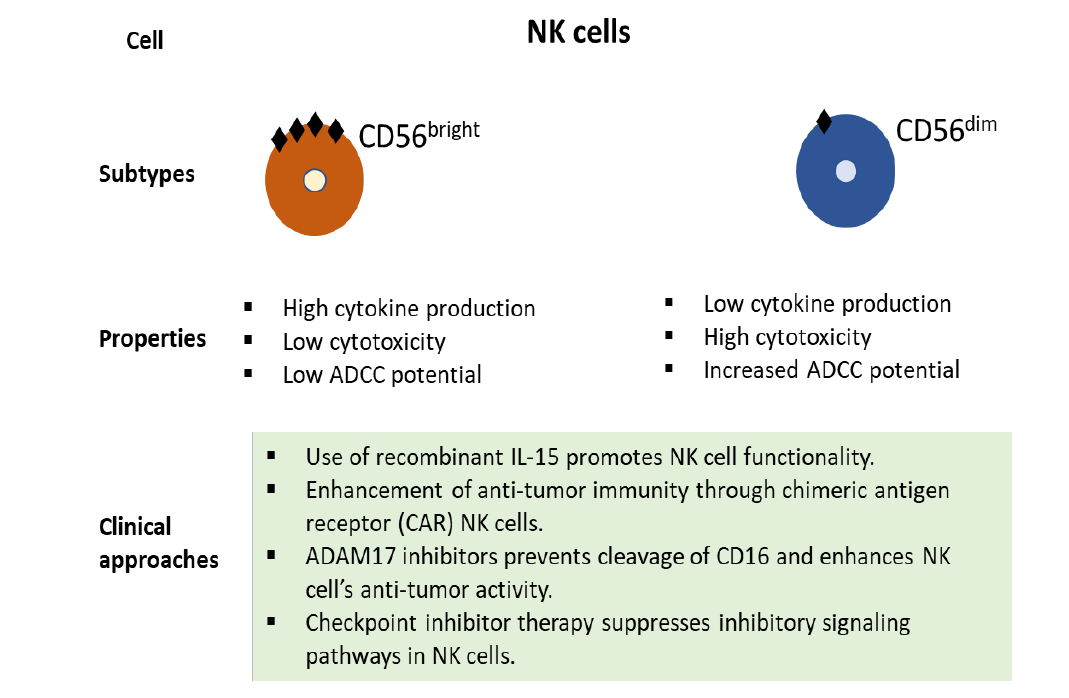
Figure 2. Broad subtypes of NK cells, their function, and potential clinical approaches with therapeutic benefits. Table 1. Recent advances in identifying prognostic roles of NK cells in NSCLC.